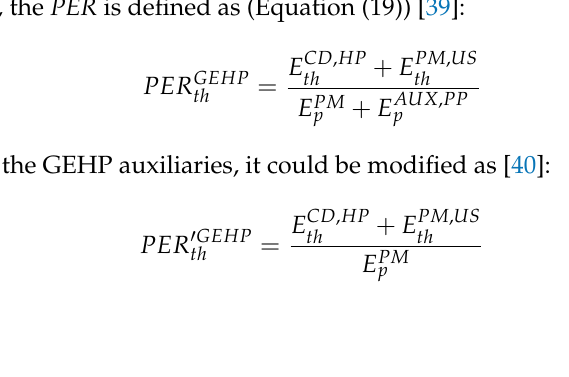
Figure 16. GEHP in heating operating mode with direct and indirect engine heat recovery.